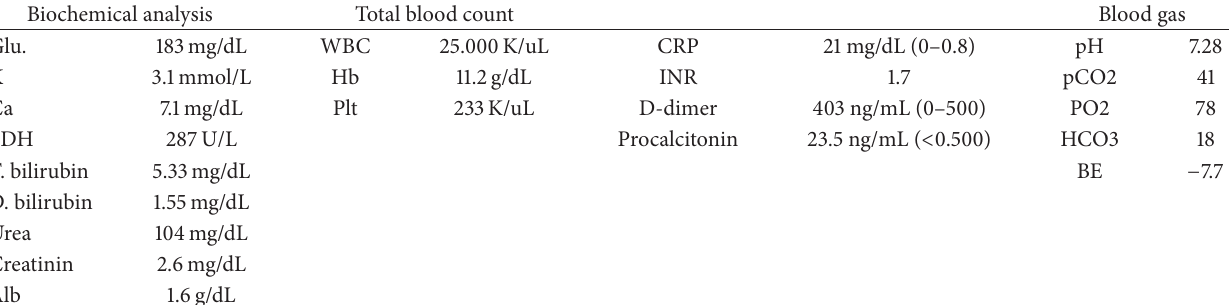
Table 2: Laboratory value of patients before NPT application.